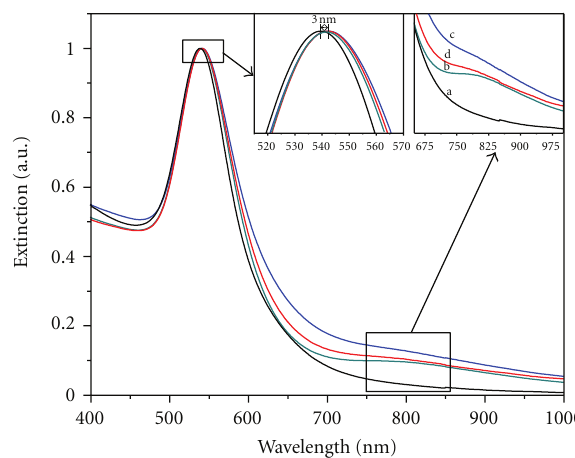
Figure 1: Normalized extinction spectra of individual gold nano- particles (spectrum a) and of PEGylated gold nano-ensembles obtained by the addition of: 20 μ L (spectrum b), 50 μ L (spectrum c) and 100 μ L (spectrum d), of mPEG-SH polymer into the colloidal